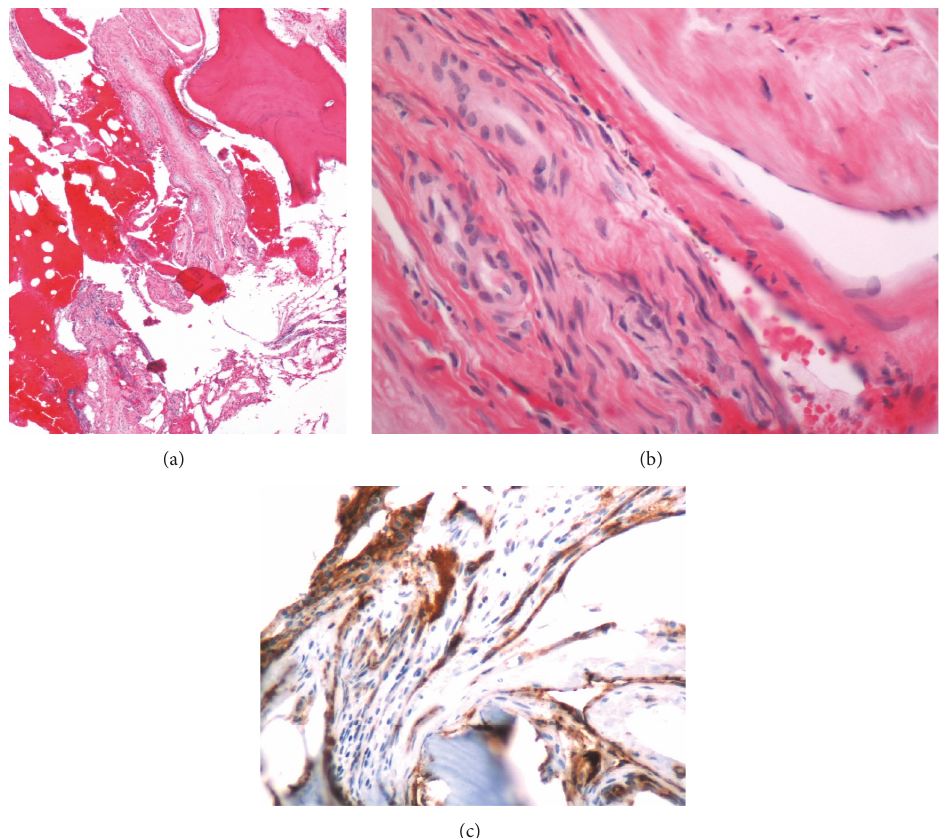
Figure 5: (a) Histological section showing multiple dilated vascular channels of irregular sizes with flat endothelial cells; (b) anterior mediastinal biopsy showing findings suggestive of a cyst wall; (c) immunohistochemistry stain for D2-40 highlighting lymphovascular